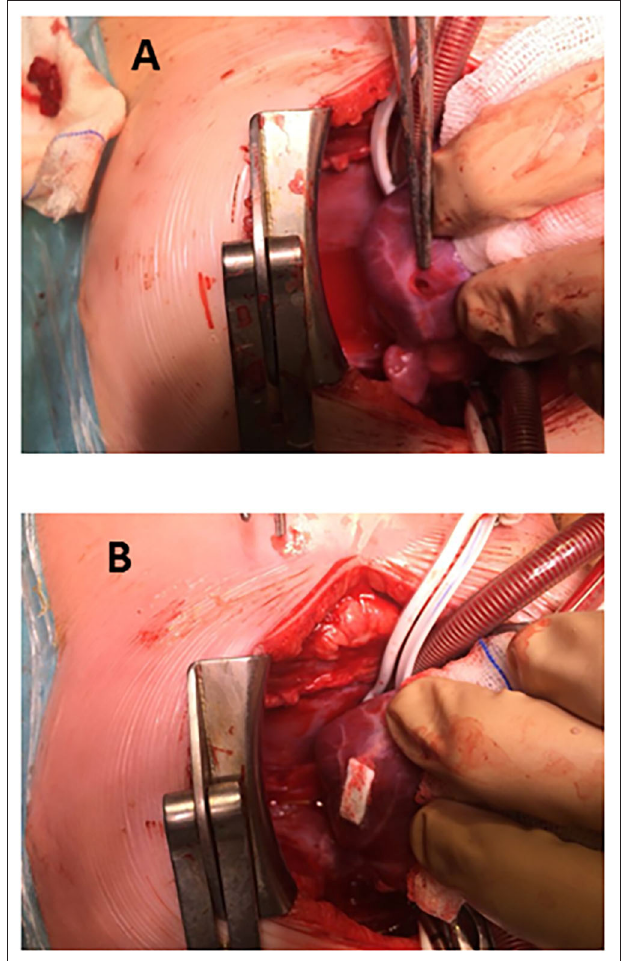
FIGURE 1 | Perventricular closure of muscular ventricular septal defect. (A) Accidental puncture in lateral wall of the left ventricle, close to a marginal coronary artery. (B) Glued-patch repair of fee-wall puncture.